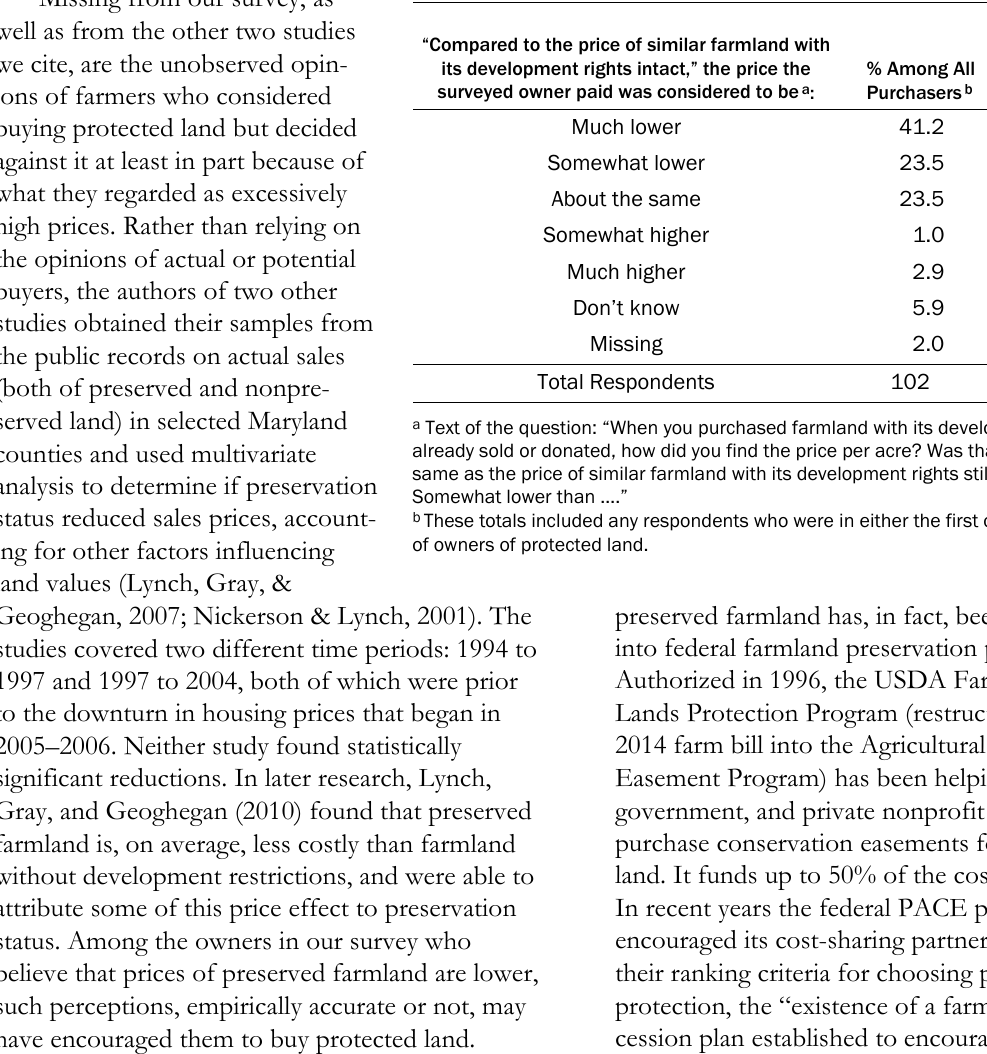
Table 5. Opinions about the Affordability of Farmland